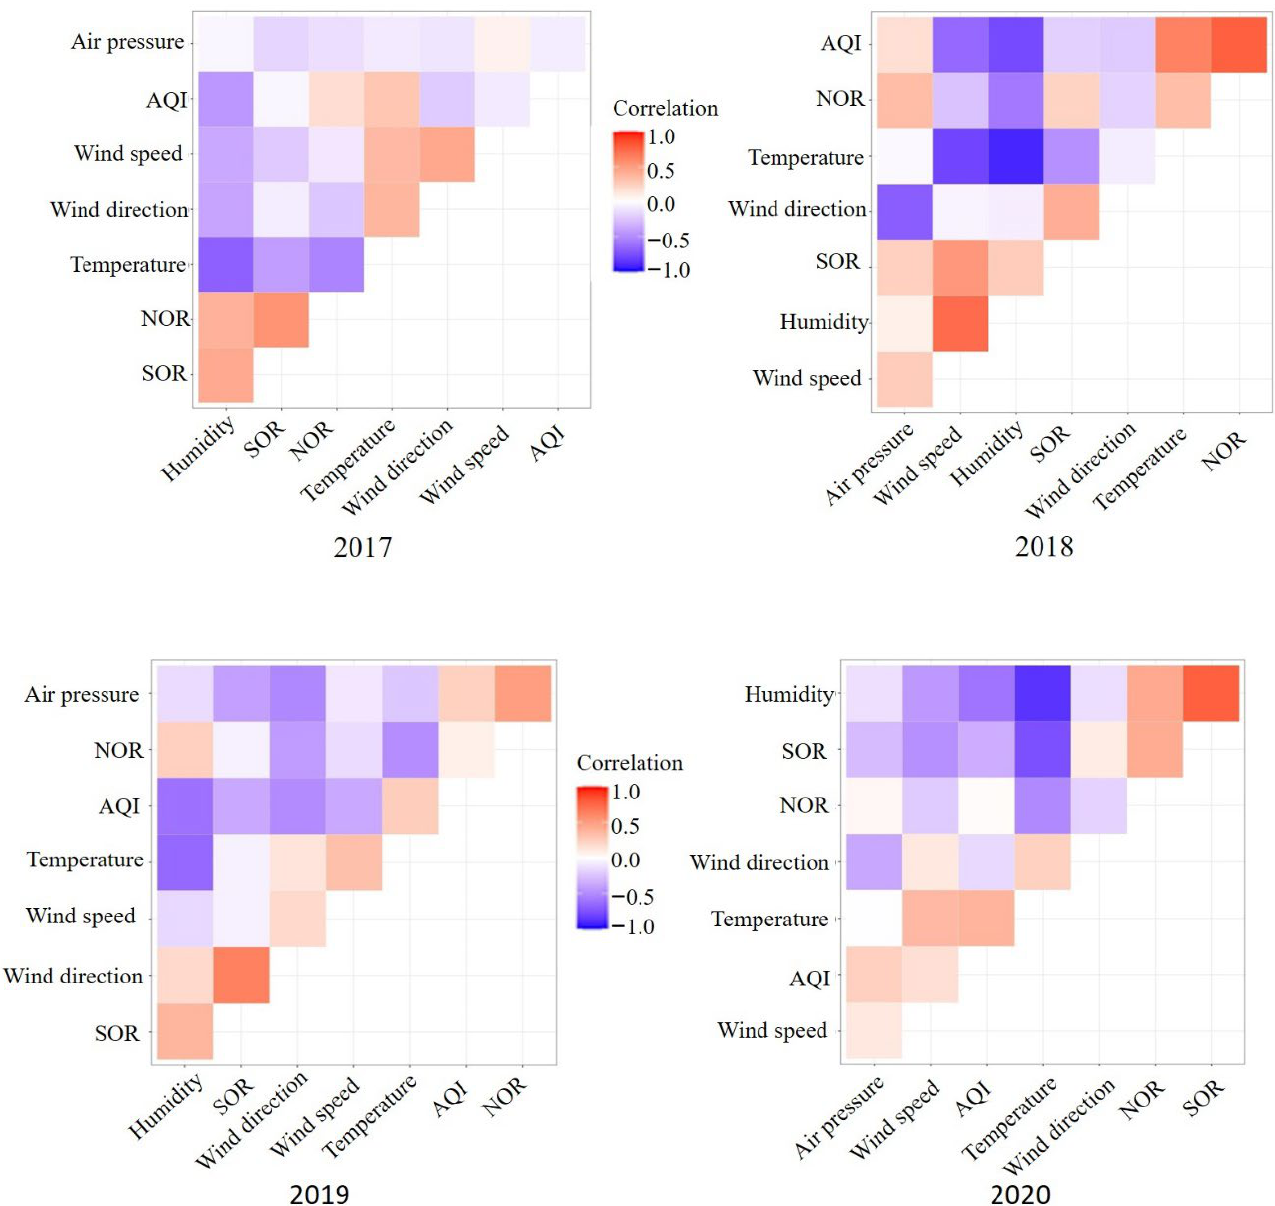
Figure 4. Spearman correlation analysis results for each year during the study period.